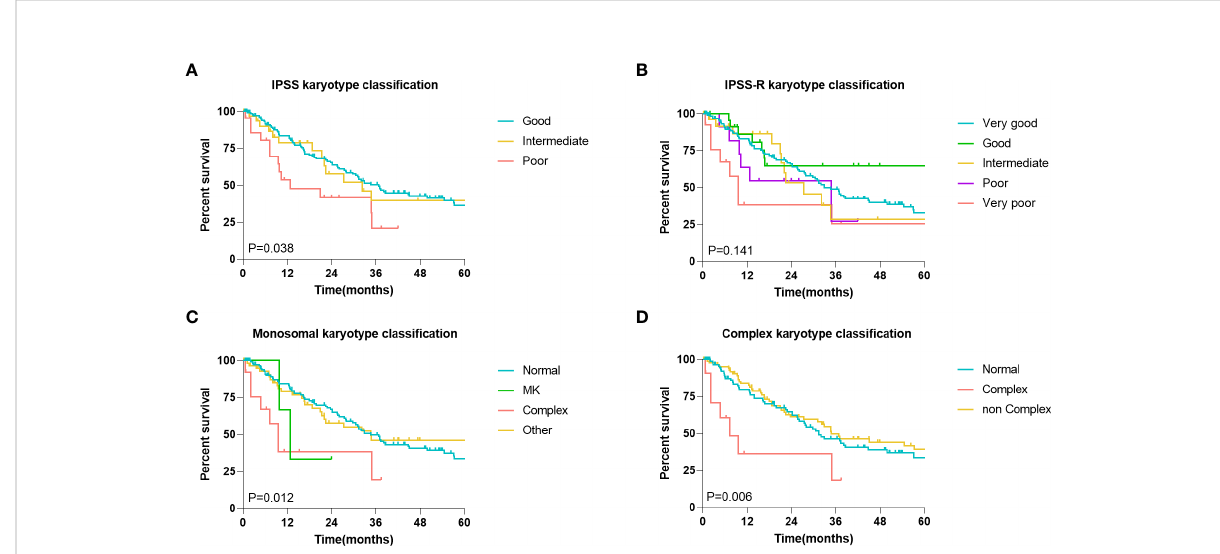
FIGURE 3 Association between karyotype classi fi cation and MDS patients ’ prognosis. (A) Kaplan-Meier analysis of MDS patients with different IPSS karyotype classi fi cation. (B) Kaplan-Meier analysis of MDS patients with different IPSS-R karyotype classi fi cation. (C) Kaplan-Meier analysis of MDS patients with different monosomal karyotypes (MK) classi fi cation. (D) Kaplan-Meier analysis of MDS patients with different complex karyotypes (CK) classi fi cation. The log-rank test was used to compare survival rates between the two